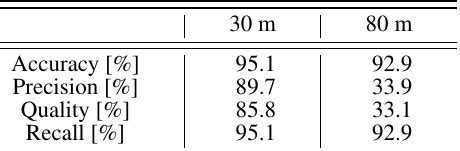
Table 3. Object detection performance of the cascade of classifier B and A. Table 4. Object detection performance of the proposed